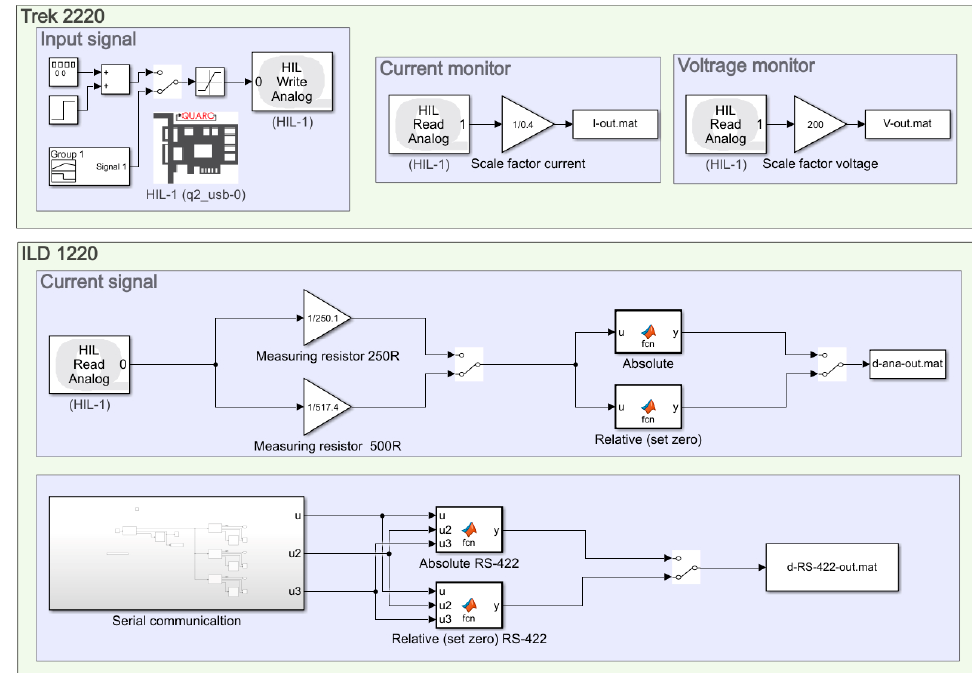
Figure 4. MATLAB/Simulink software model.